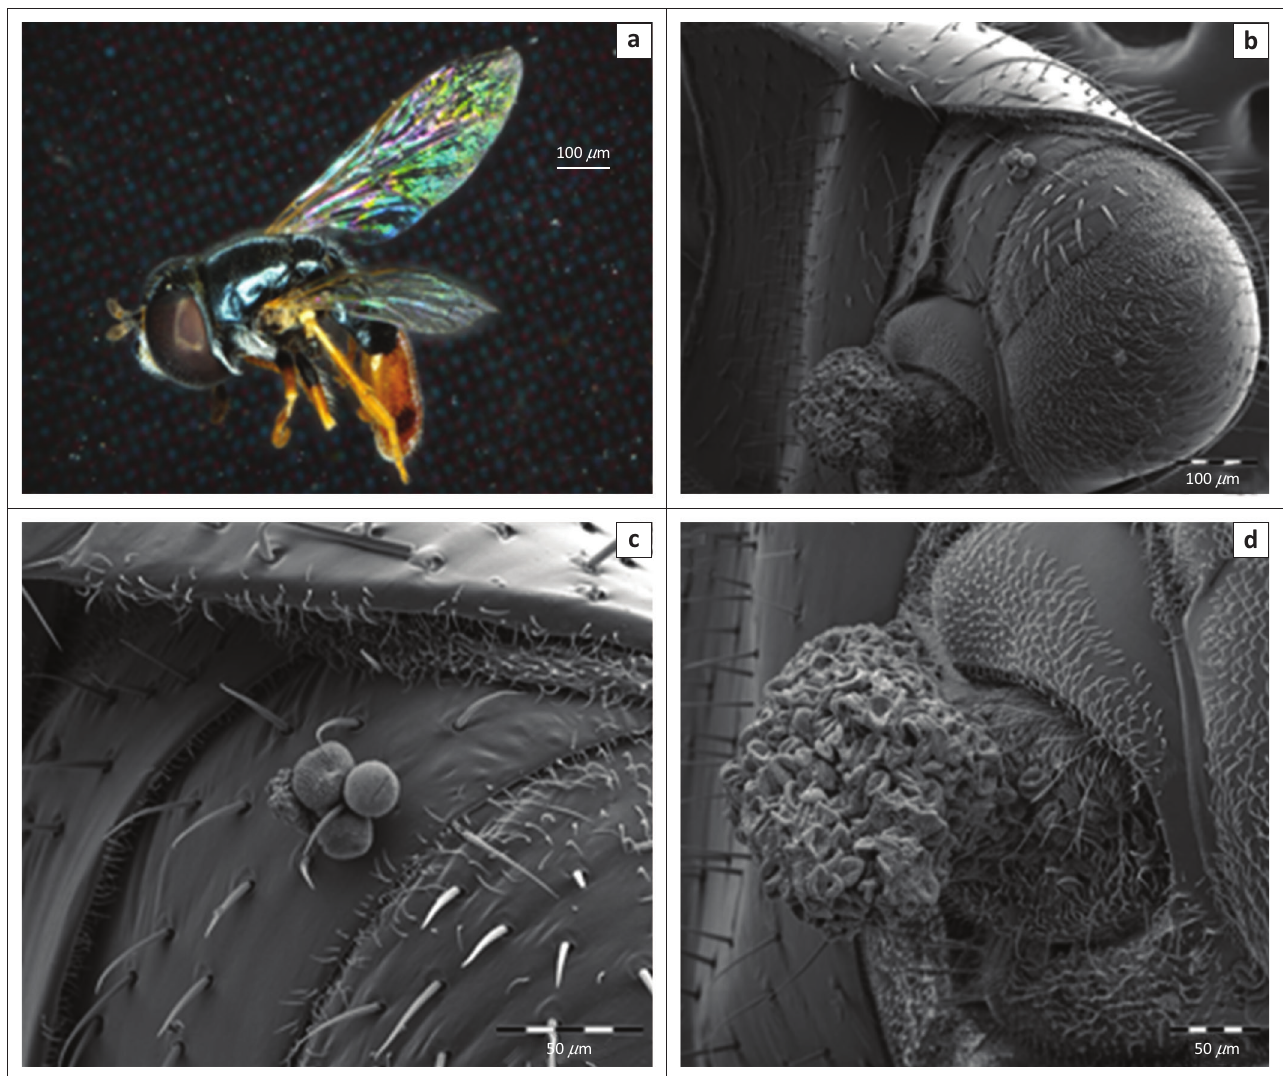
FIGURE 5: (a) Stereomicrograph of Paragus sp. (Syrphidae). Scanning electron micrographs of Frithia humilis pollen grains above the anus (b), on the body (c) and on the anus